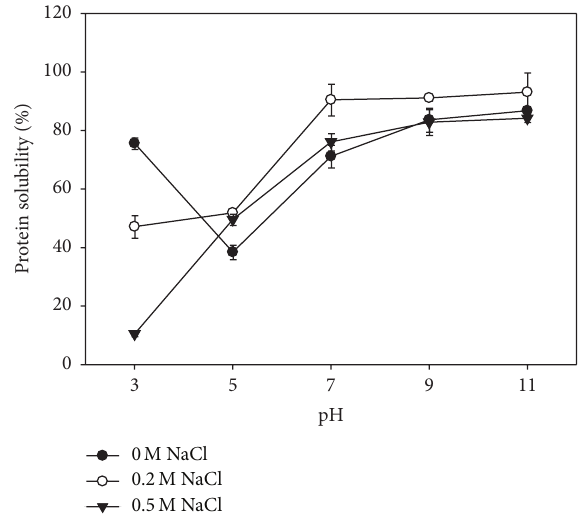
Figure 1: Effect of pH and NaCl concentration on protein solubility of SP from jumbo squid mantle. Data represent the mean ± standard deviation ( 𝑛 = 3